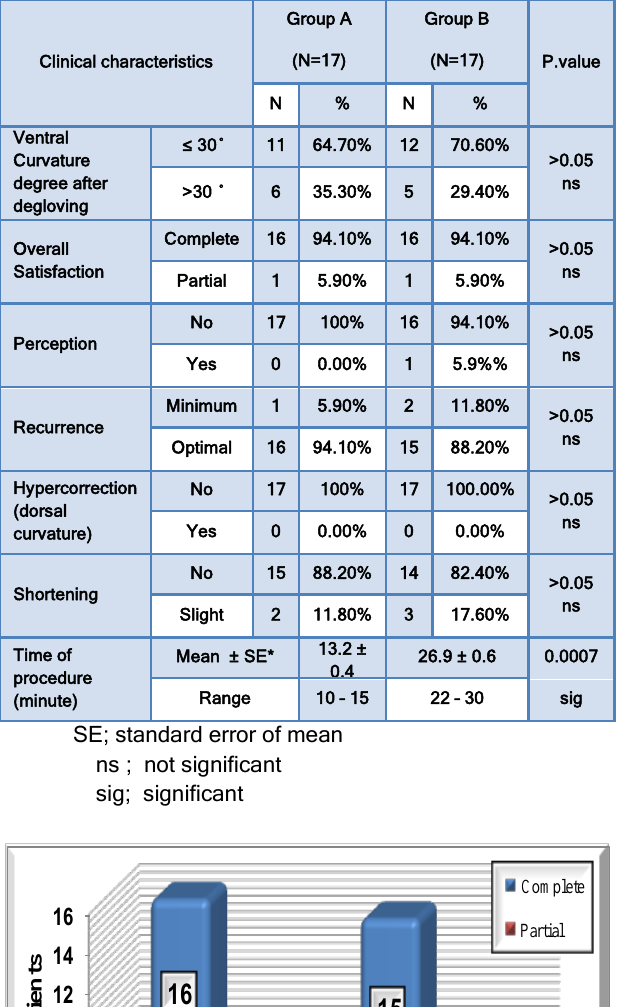
Table 2: The results and clinical characteristics of patients Clinical characteristics